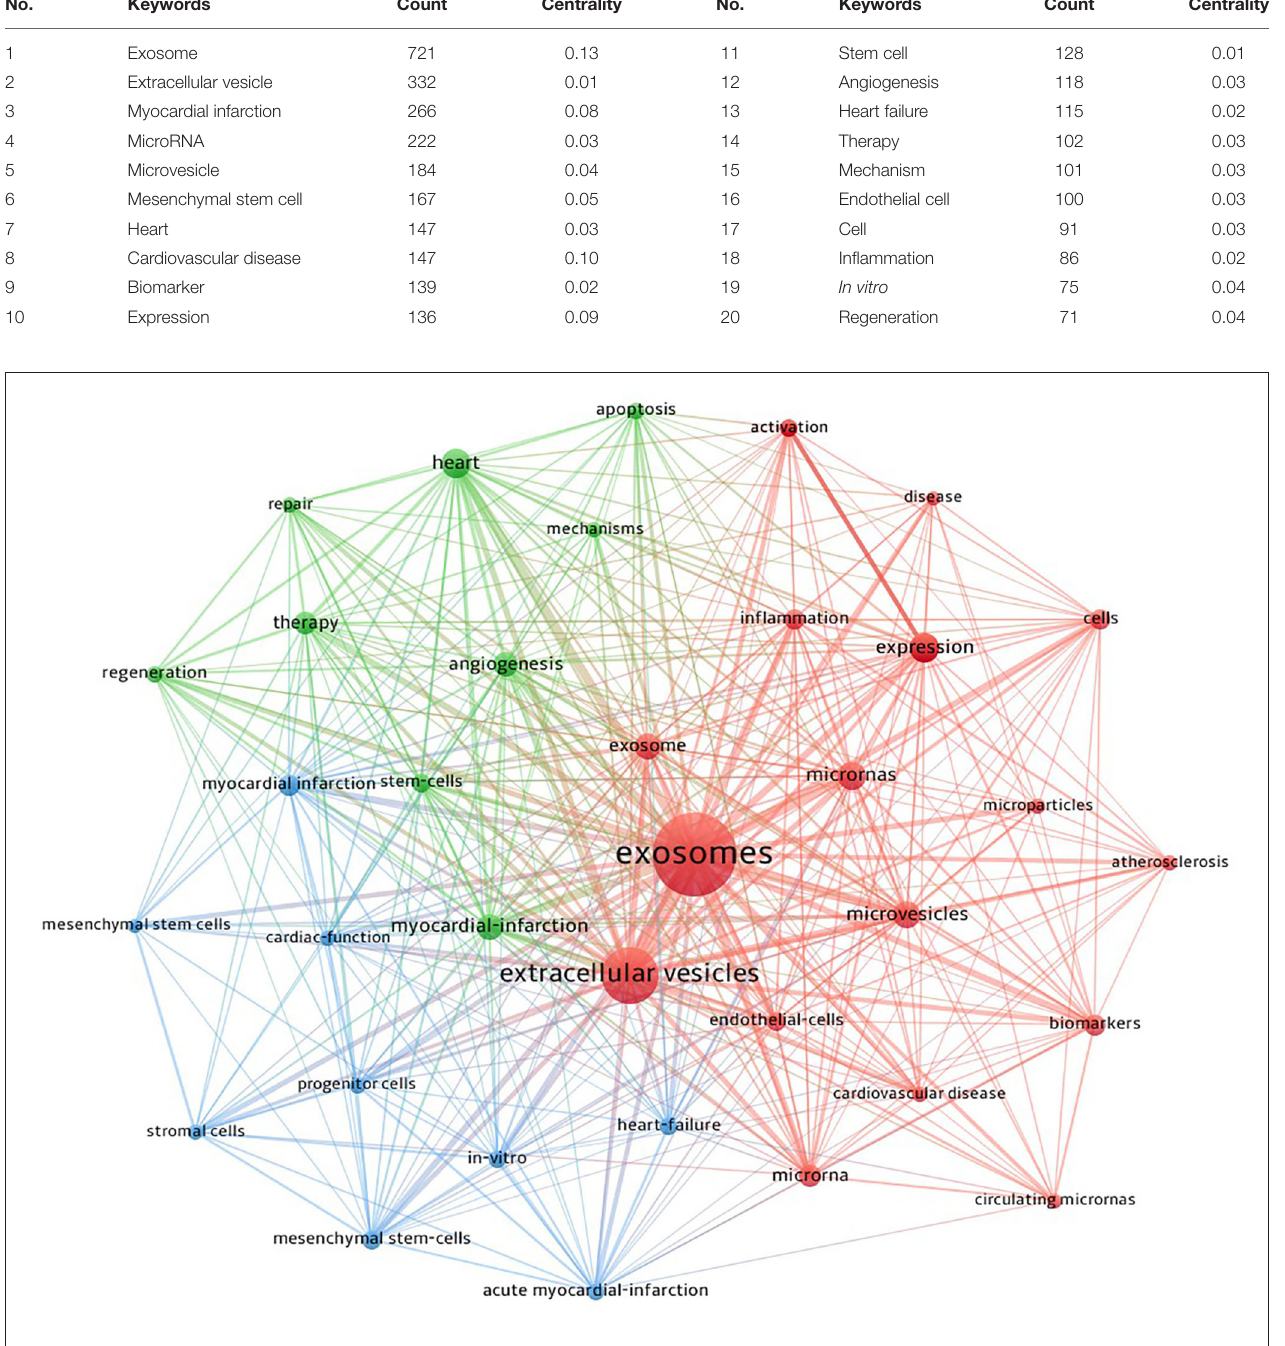
FIGURE 9 | CiteSpace visualization map of keywords clustering analysis on exosomes in